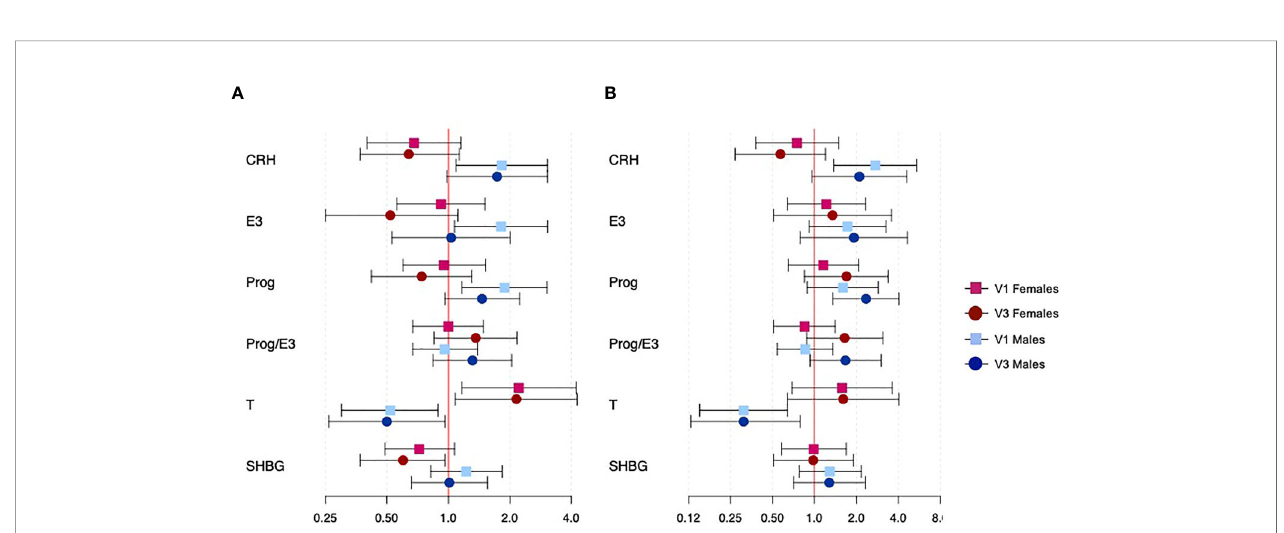
FIGURE 2 | Associations between CRH and reproductive hormone concentrations and binary outcomes of overall and spontaneous PTB, speci fi c to fetal sexes and study visit. Panel (A) shows overall PTB and panel (B) shows spontaneous PTB. Effect estimates represent the odds of overall or spontaneous PTB with an interquartile range increase in hormone concentration. Red and blue estimates correspond to female and male fetuses, respectively. Squares denote effects from hormones at visit 1, while circles denote effects from hormones at visit